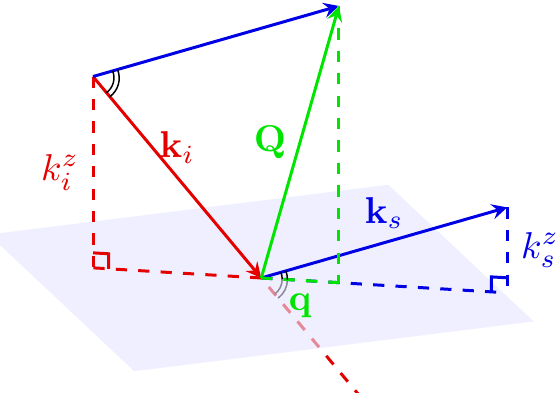
Figure 1: Schematic showing the M-EELS scattering geometry. Here, k menta of the incident and scattered electron, respectively, and Q is the momentum transfer, the in-plane component of which, q = ( q of-plane momentum components, k z way (see Section 4 and Appendix